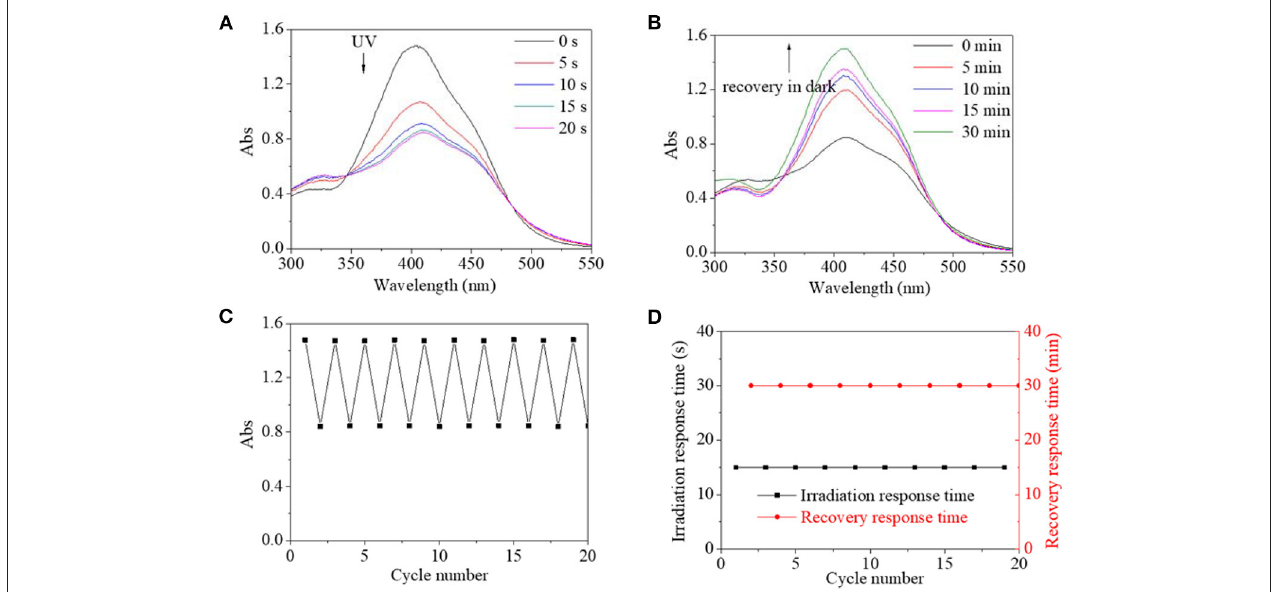
FIGURE 6 | UV spectra of PBLG2 DMF solution as a function of irradiation time (A) and recovery time (B) . (C) Absorbance at 400/410nm of PBLG2 DMF solution as a function of cycle number. (D) Irradiation response time and recovery response time as a function of cycle number. Irradiation was performed under UV light, and recovery process was performed under darkness and room temperature. Polymer concentration was 0.8